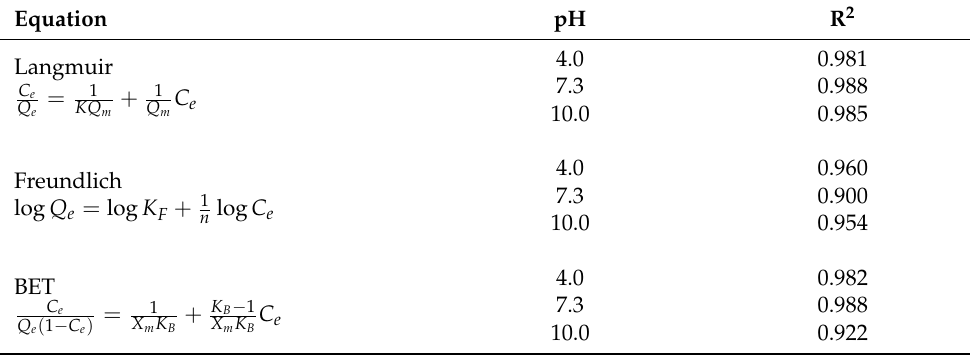
Table 3. Experimental R 2 at three pH values for each adsorption model.